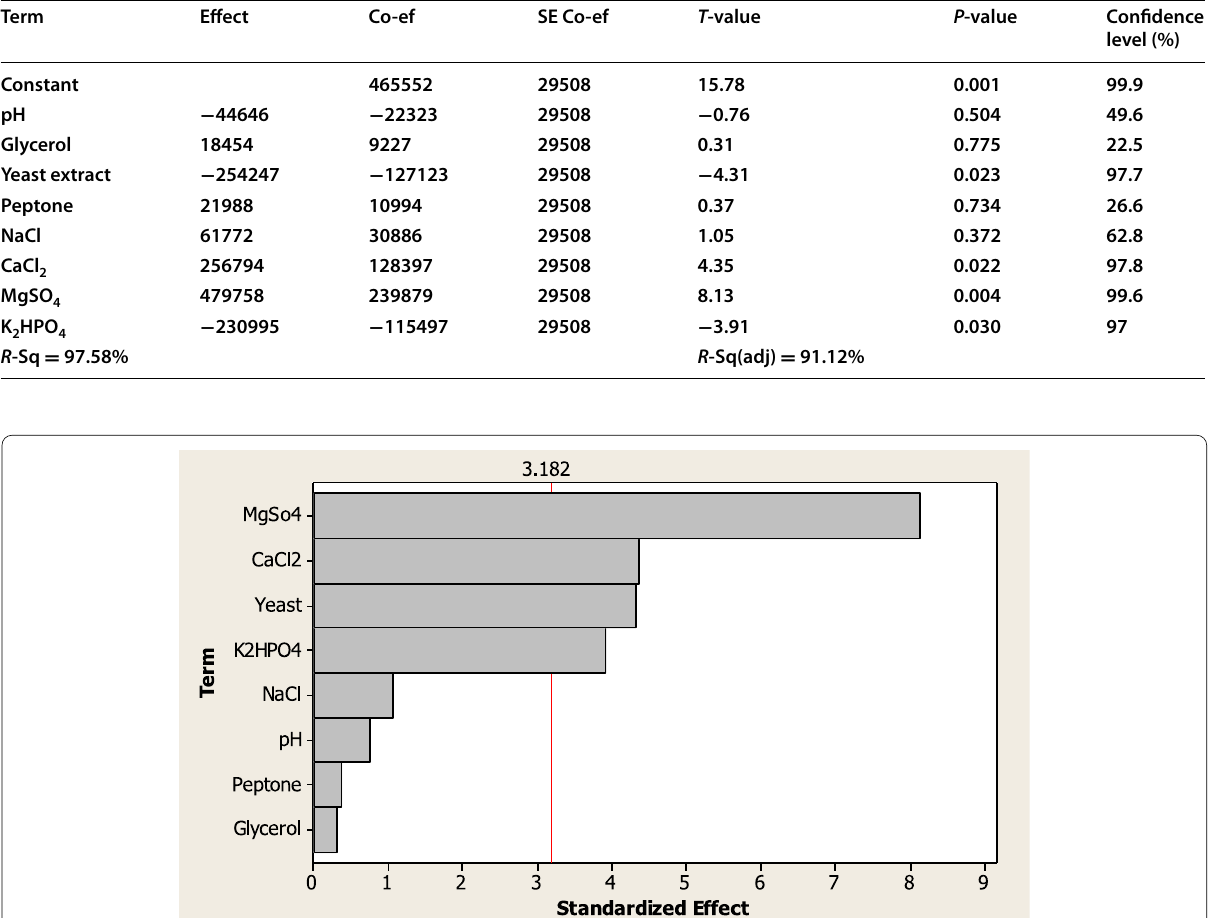
Table 5 Statistical analysis of PBD for BL of V . sp. 6HFE